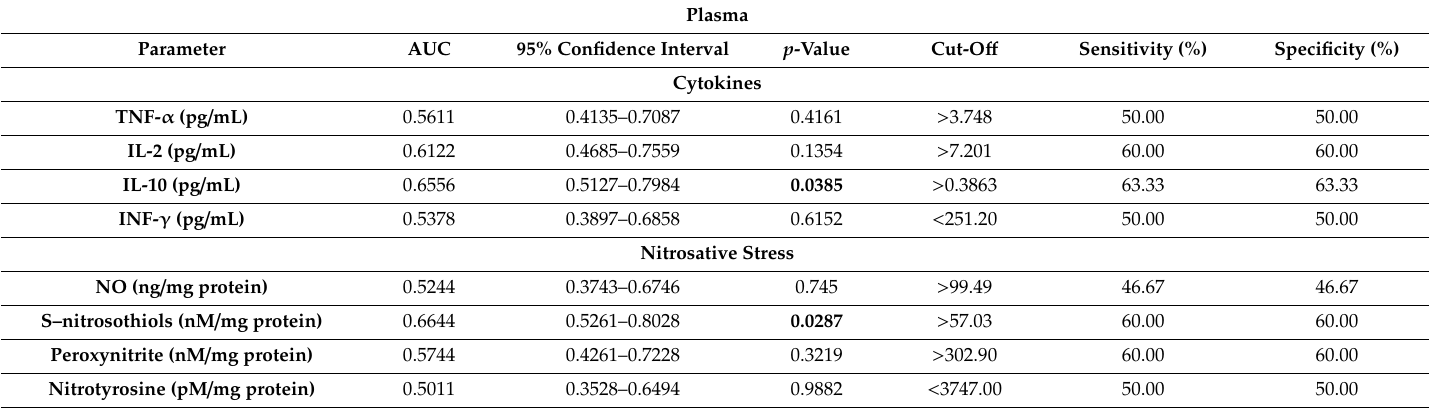
Table 3. ROC analysis of the assessed cytokines and nitrosative stress biomarkers in the plasma of plaque psoriasis patients with normal salivation and